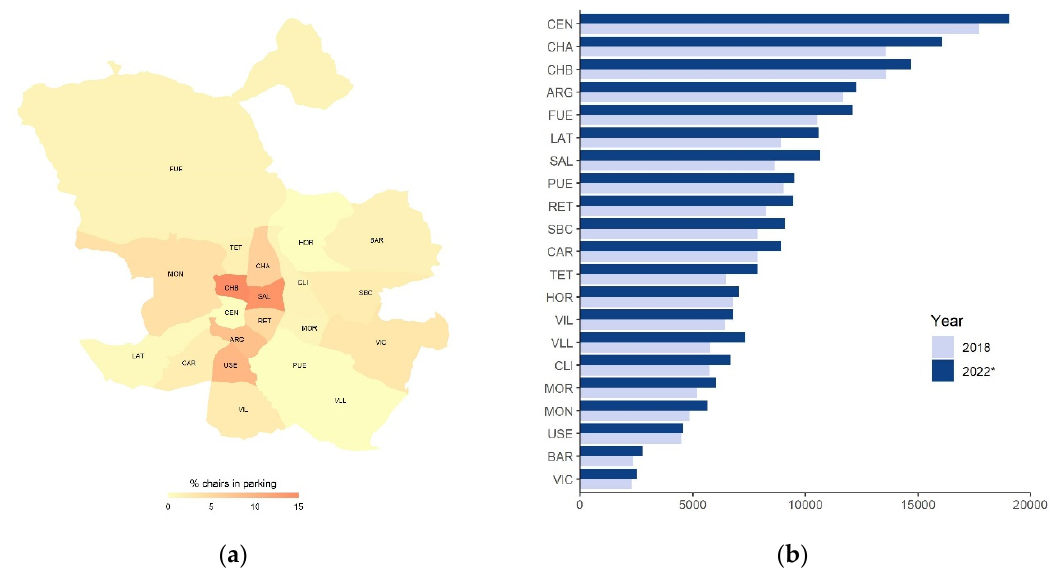
Figure 9. ( a ) Proportion of seats (on restaurant terraces) authorised to occupy public parking areas (April 2021) with respect to the total number of seats authorised in each district; ( b ) number of seats (on restaurant terraces) in April 2018 (blue light) and estimated for 2022, taking into account the data available in April 2021, and the seats that occupy parking spaces (dark blue). Compiled by the authors using data from Madrid City Council’s open data portal [78]. “*” stands for estimated (not observed) data.